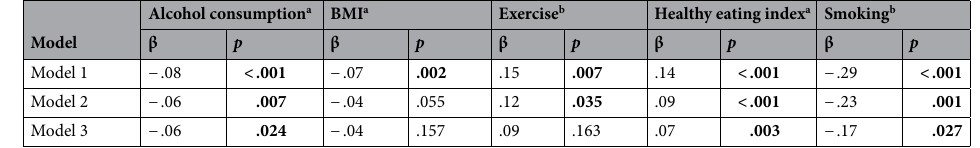
Table 6. Gratitude as a predictor of alcohol consumption, BMI, exercise, healthy eating index, and smoking. N = 1800. β = standardized slope coefficient. Bolded p values indicate significance at the .05 level. Model 1 was an unadjusted model with dispositional gratitude as the only predictor without entering any other covariates. Model 2 additionally controlled for age, sex, education attainment, household income, race, and the use of hyperlipidemic agent medication. Model 3 additionally controlled for dispositional optimism, agreeableness, conscientiousness, extraversion, emotional stability, and openness to experience. a Linear regression. b Logistic regression.